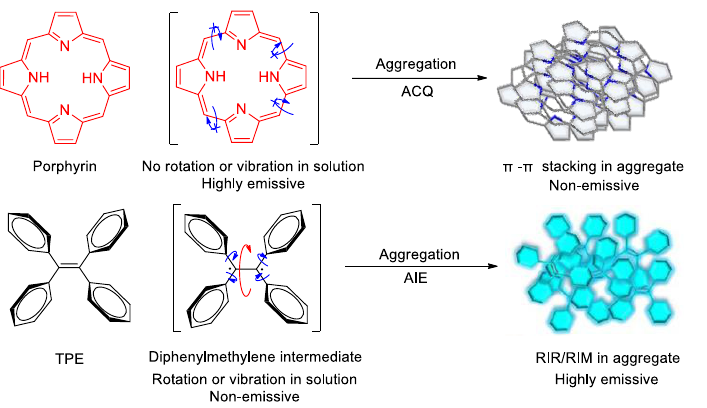
Figure 1. Schematic diagrams illustrating fluorescence quenching of traditional photosensitizers (PSs) such as porphyrin in their aggregate states vs. fluorescence turn-on effect of aggregation-induced emission (AIE) fluorogens such as tetraphenylethene (TPE) upon aggregate formation. Adapted and modified with permission from reference 15 (copyright 2015, American Chemical Society).